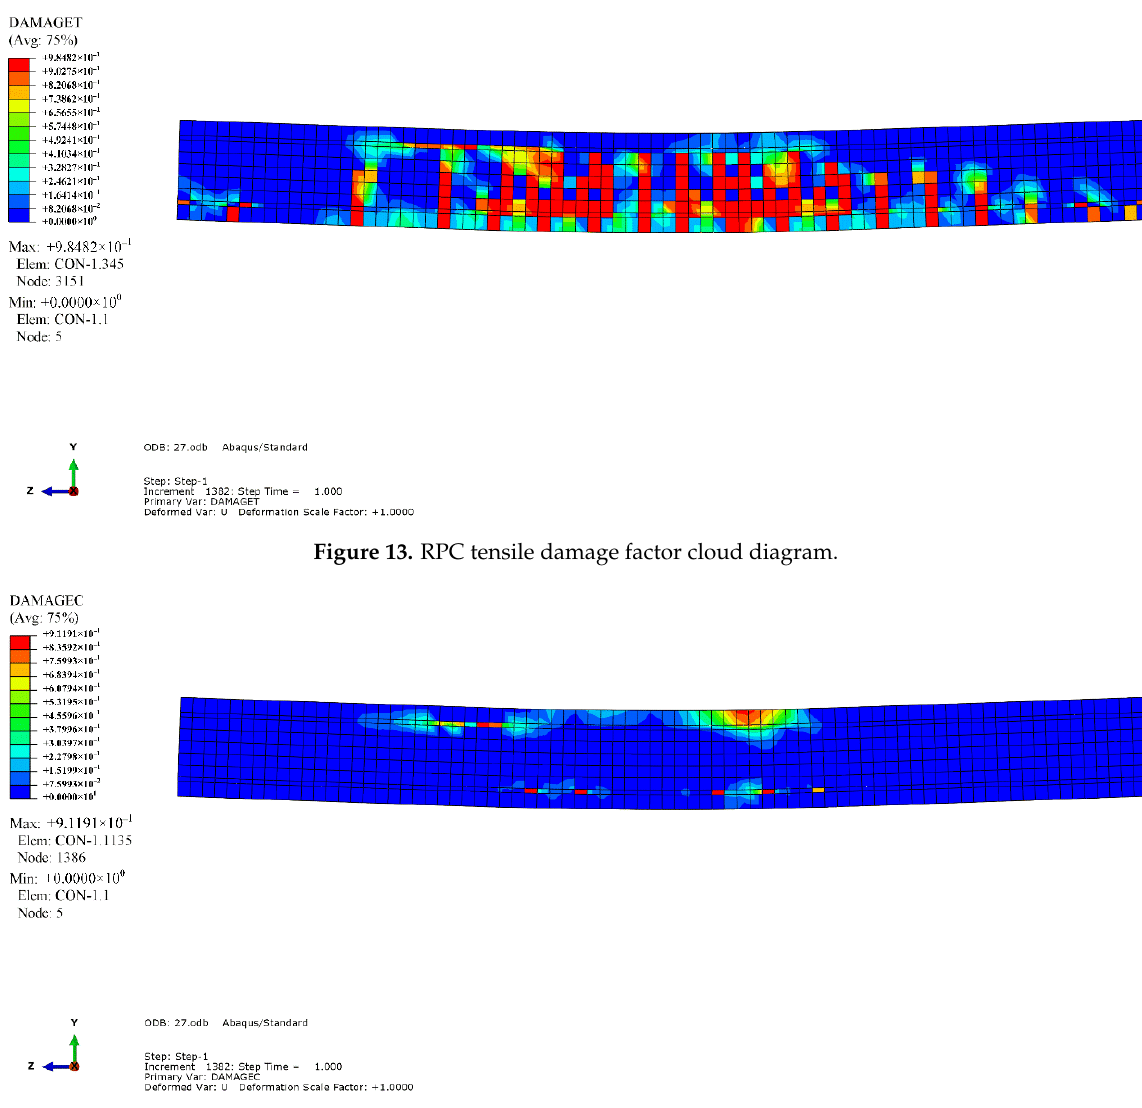
Figure 12. Von-Mises stress diagram of section steel.